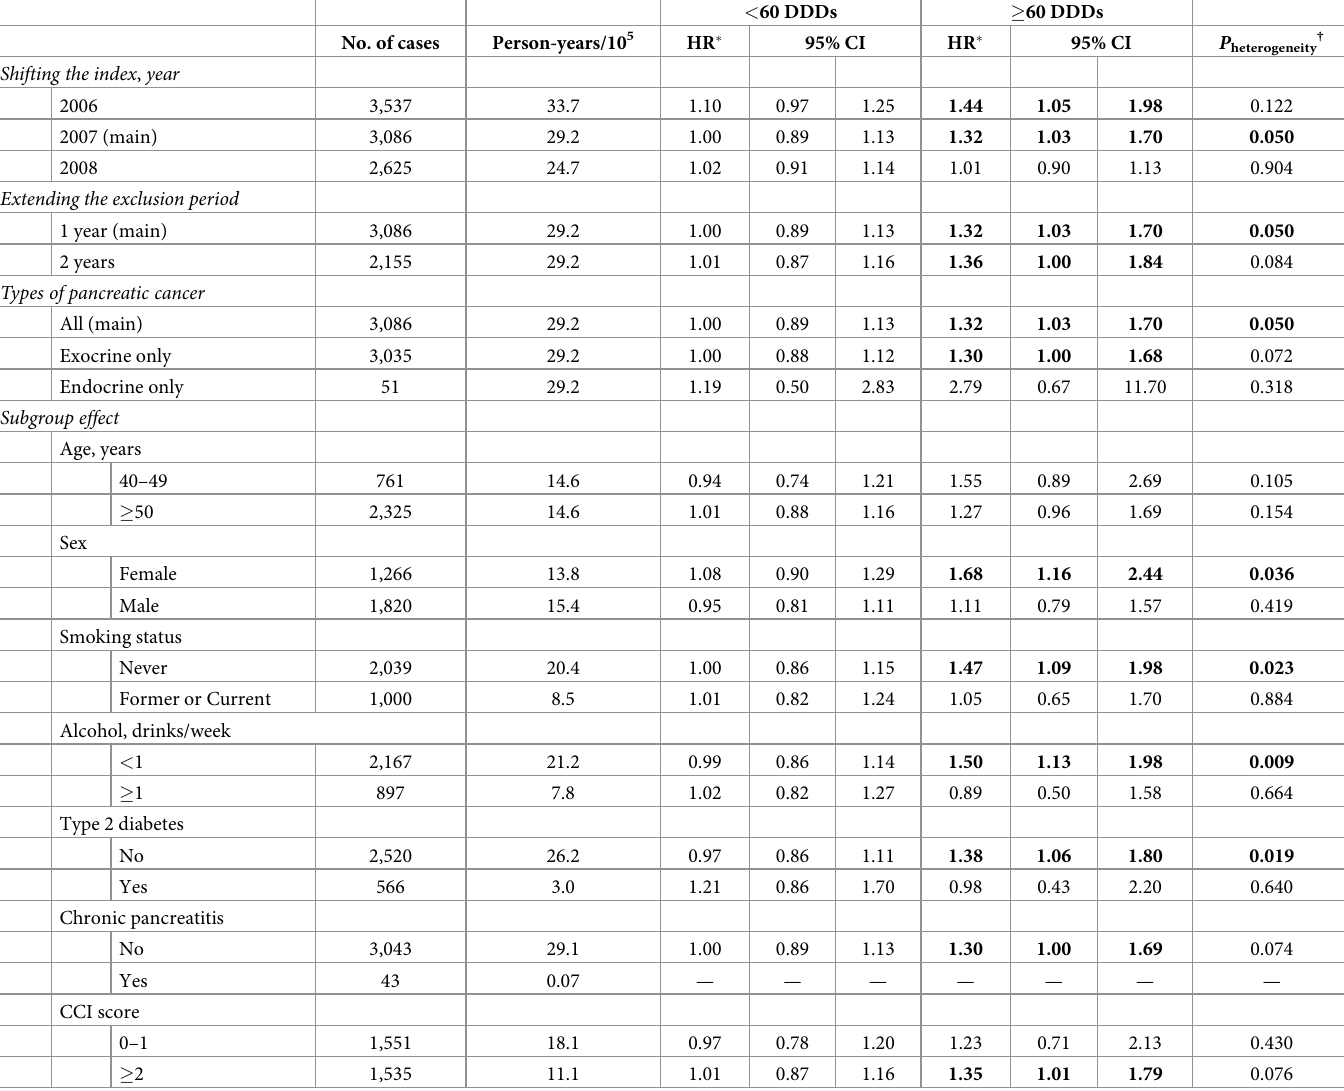
Table 3. Risk of PPI exposure for pancreatic cancer (case) development among various risk groups (reference: PPI